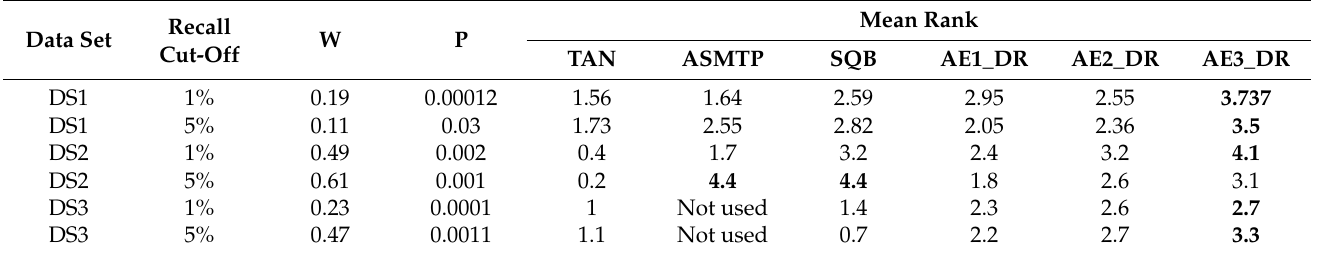
Table 10. The Rankings of TAN, ASMTP, SQB, AE1-DR, AE2-DR, and AE3-DR approaches Based